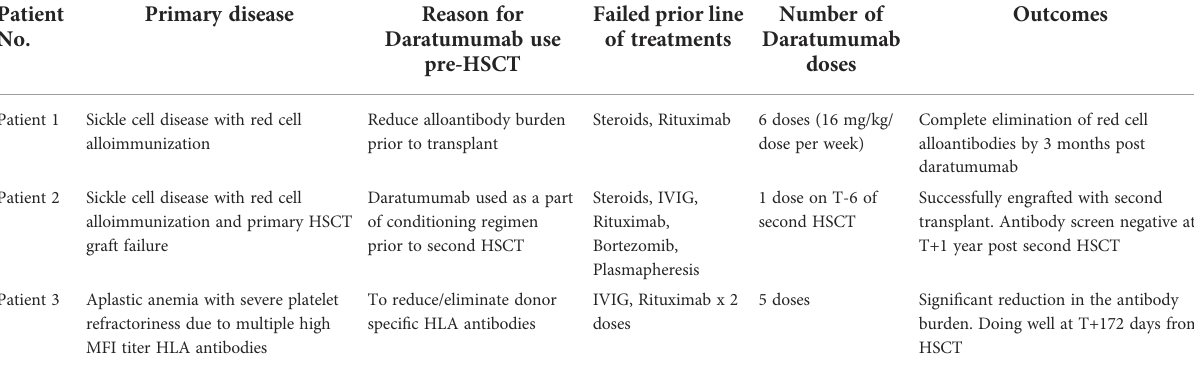
TABLE 2 Summary of our patients with indications for Daratumumab and outcomes. Patient